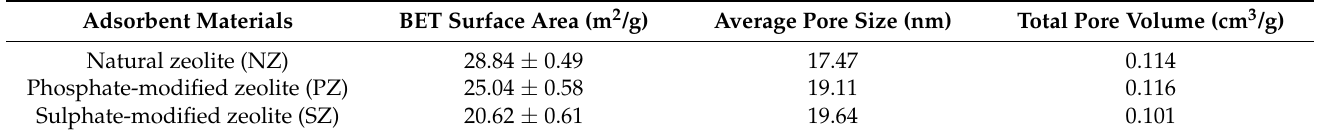
Table 1. The textural properties of adsorbent